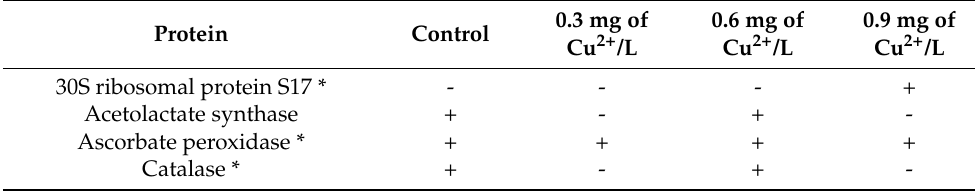
Table 4. Identified proteins related to response to stress.